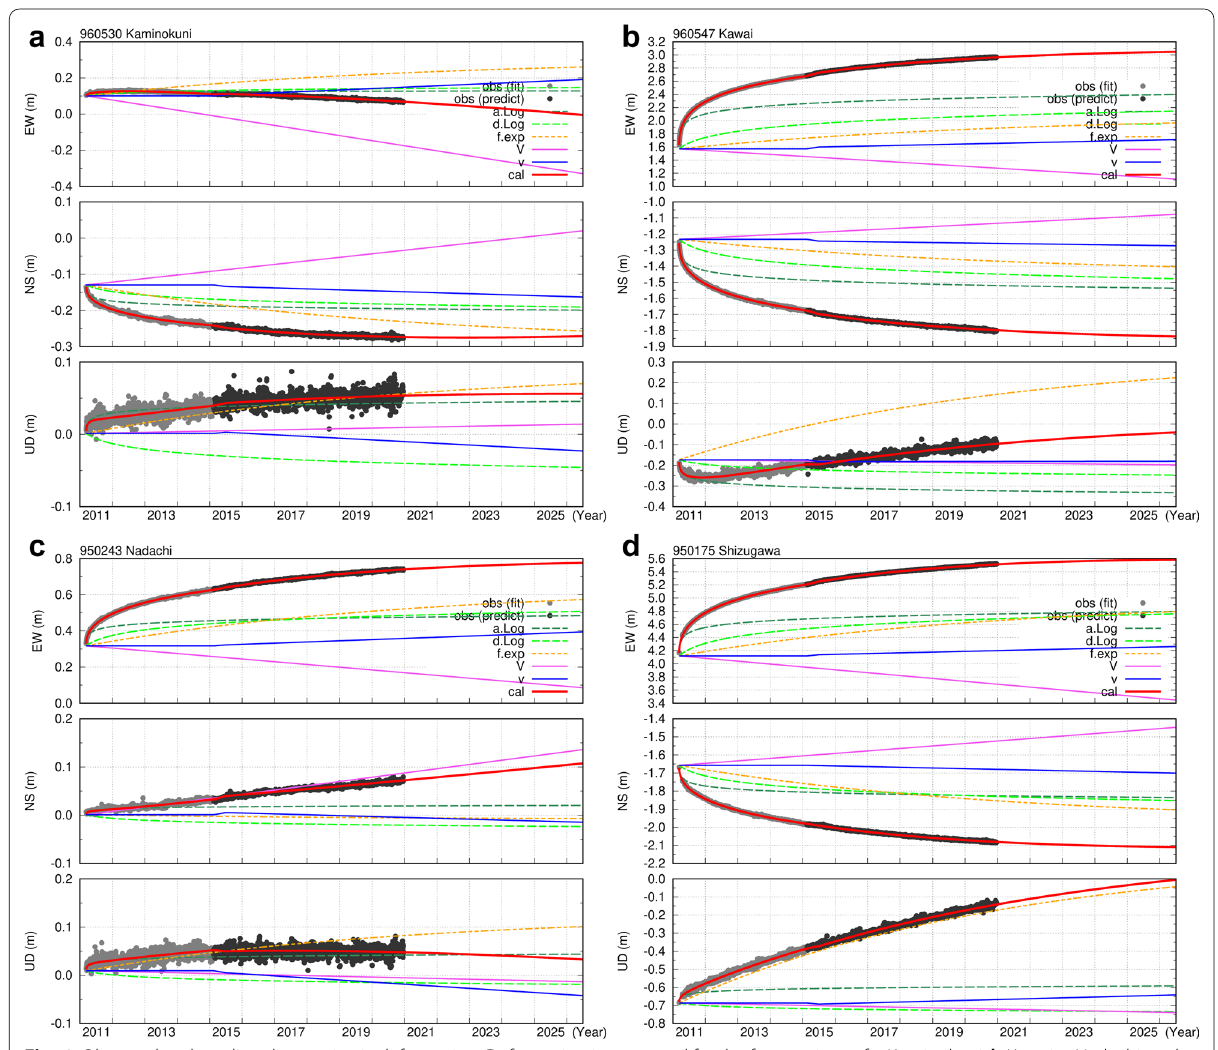
Fig. 6 Observed and predicted postseismic deformation. Deformation is presented for the four stations of a Kaminokuni, b Kawai, c Nadachi, and d Shizugawa (Fig. 1). The three components of east–west (EW), north–south (NS), and up–down (UD) are drawn for each station from the day after the 2011 Tohoku-Oki earthquake to 2026.5. Gray dots indicate the daily observations used for the fitting period of the 3.9-year model. Black dots represent the daily observations during the prediction period. Red lines are the predicted values based on Eqs. (3) and (4), and other lines represent specific terms in Eqs. (3) and (4) (see text)